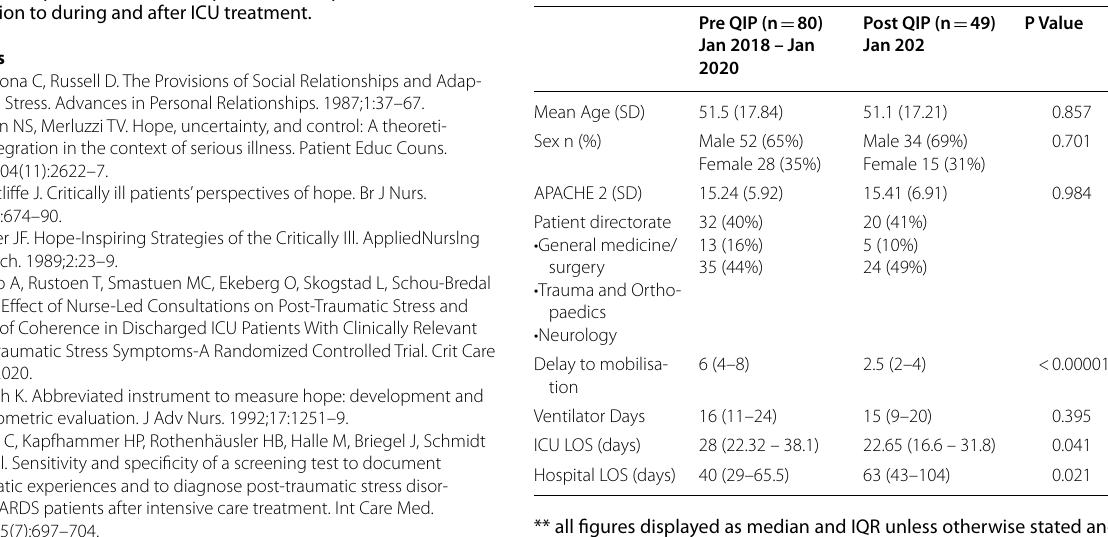
(Table 1). Patients during the QIP had significantly shorter delays to mobilisation (2.5 vs 6 days, p < 0.05), shorter ICU LOS (22.65 vs 28